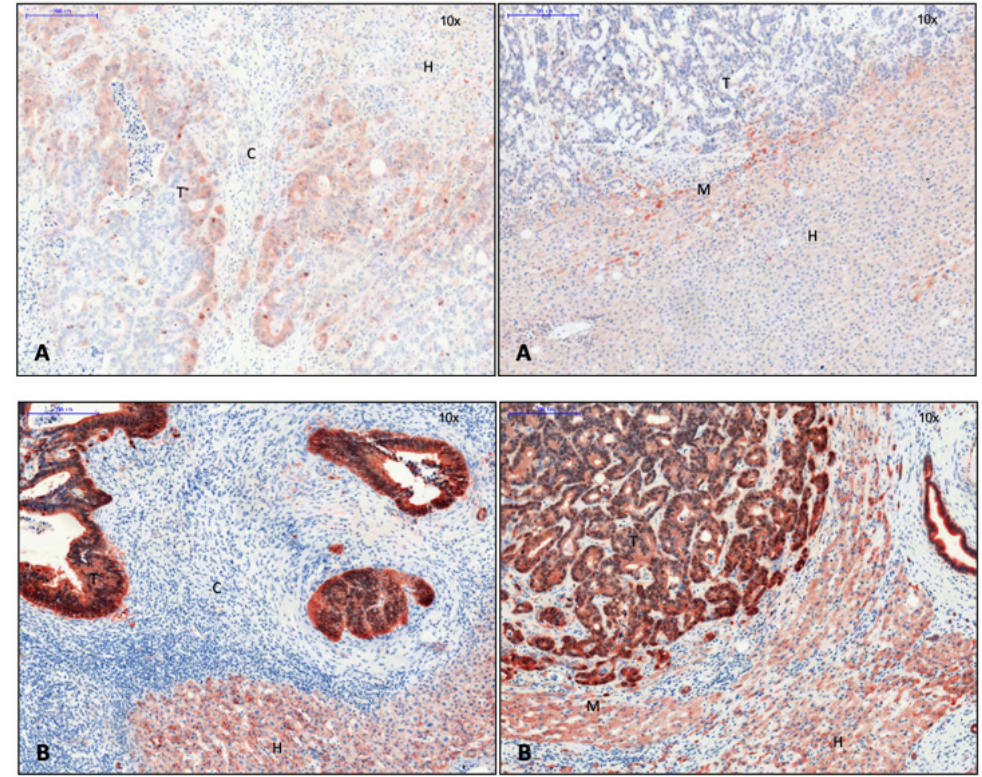
Figure 4. Left: capsule; right: no capsule. ( A ) The pGSK-3-ß immunohistochemistry, 10 × magnification. Expression of pGSK-3-ß in cytoplasm of hepatocytes near the tumor margin in CRLM without capsule and in tumor cells at the tumor margin in CRLM with capsule. ( B ) The ß-catenin immunohistochemistry, 10× magnification. Expression of ß-catenin in nuclei of tumor cells, in membrane-bound hepatocytes. Cellular accumulation and deposit of ß-catenin in the nucleus of the tumor cell are associated with loss of E-cadherin and known as a phenomenon of EMT. Legend: T, tumor; H, hepatocytes; M, tumor margin; C, capsule.